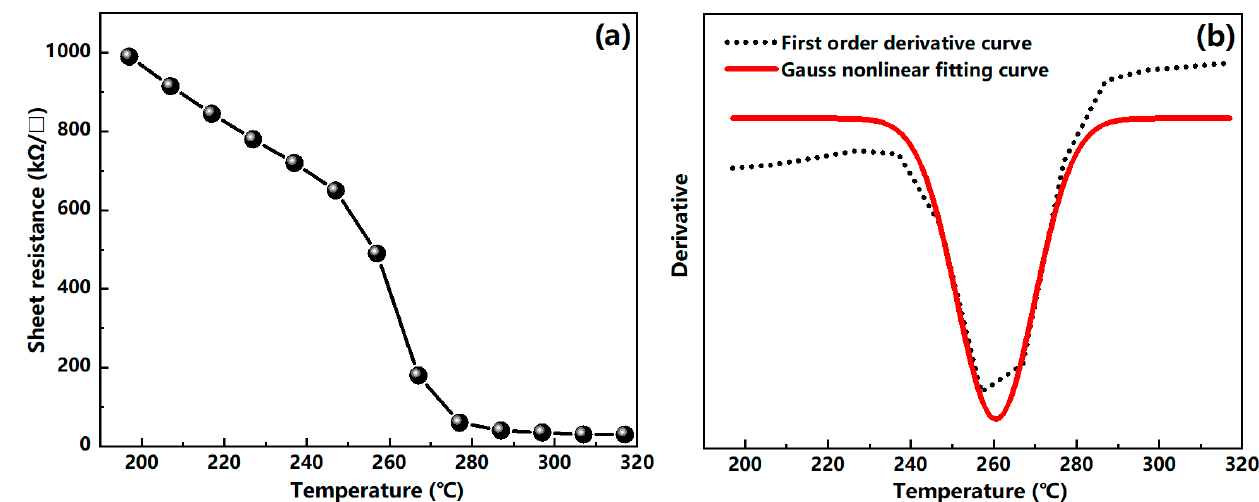
Figure 7. ( a ) Temperature–sheet resistance characteristic curve; ( b ) the first-order derivation (black dotted line) and the Gaussian nonlinear fitting (red line) on the temperature–sheet resistance characteristic curve.